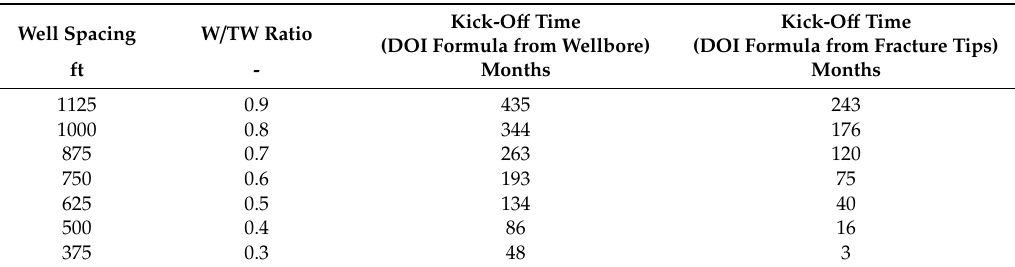
Figure 13. Kick-off times due to onset of well interference for different well spacing using (1) depth of investigation (DOI) equation from wellbore, (2) DOI formula from hydraulic fracture tip, and (3) KAPPA simulation model. Table 3. Corresponding kick-off times for onset of well interference for different well spacings using (1) DOI formula with pressure transient starting from horizontal wellbore, and (2) DOI formula with pressure transient starting from hydraulic fracture tips.